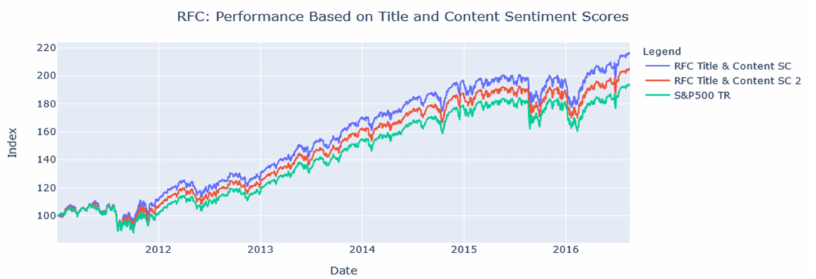
Table 9. Performance measures of strategies based on RF classification on content sentiment scores from 1 January 2011 to 16 August 2016. Return p.a.